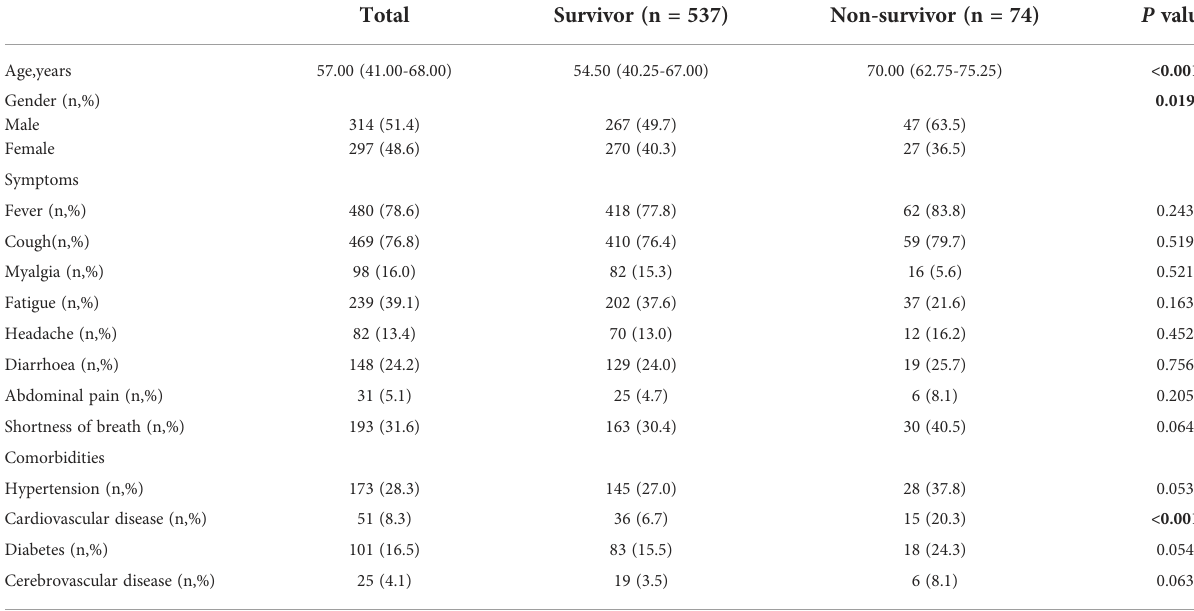
TABLE 1 Baseline characteristics of survivor and non-survivor of COVID-19